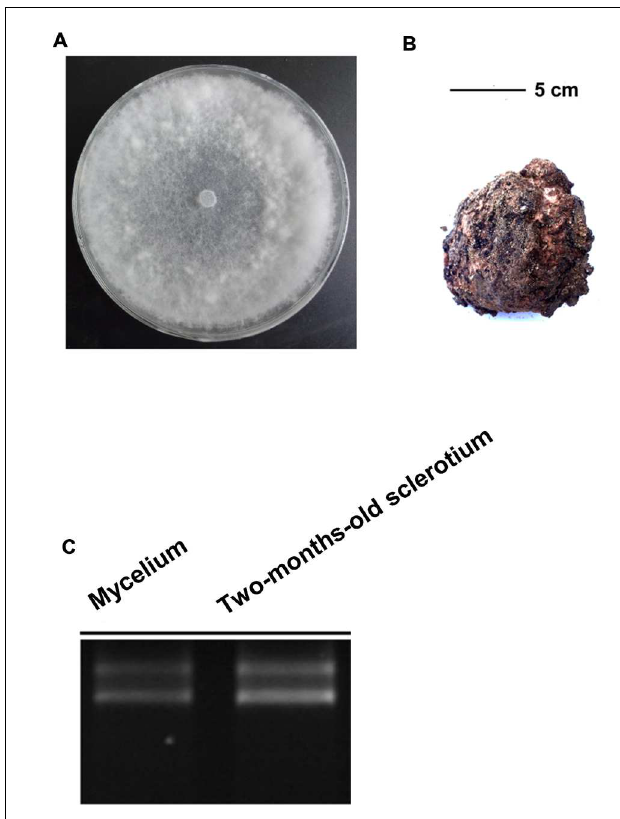
FIGURE 1 | The mycelium and sclerotia of W. cocos used for De Novo Sequencing. (A) Colony morphology W. cocos mycelium grown on PDA for 7 days at 25 ◦ C. (B) W. cocos sclerotium of 2-months-old, scale bar = 5 cm. (C) The total RNA isolated from mycelium and 2-months-old